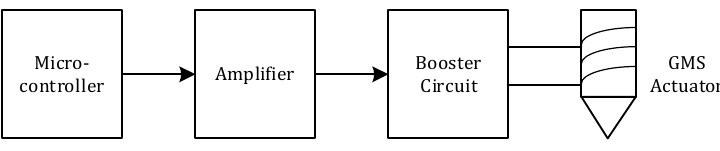
Figure 3. Principle of the coded pulse signal generator.